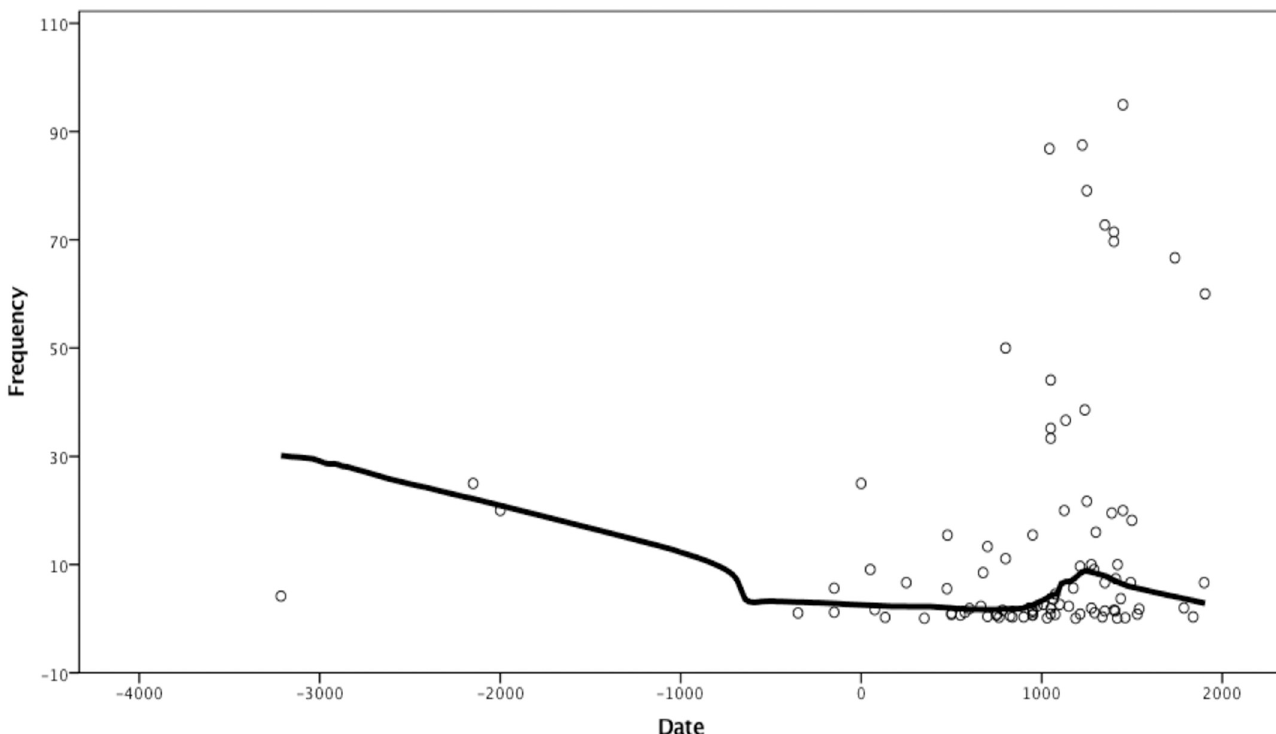
Fig 3. Frequency of skeletal signs of leprosy by date. LOESS curve fitted with 60% of points included and tricube kernel.